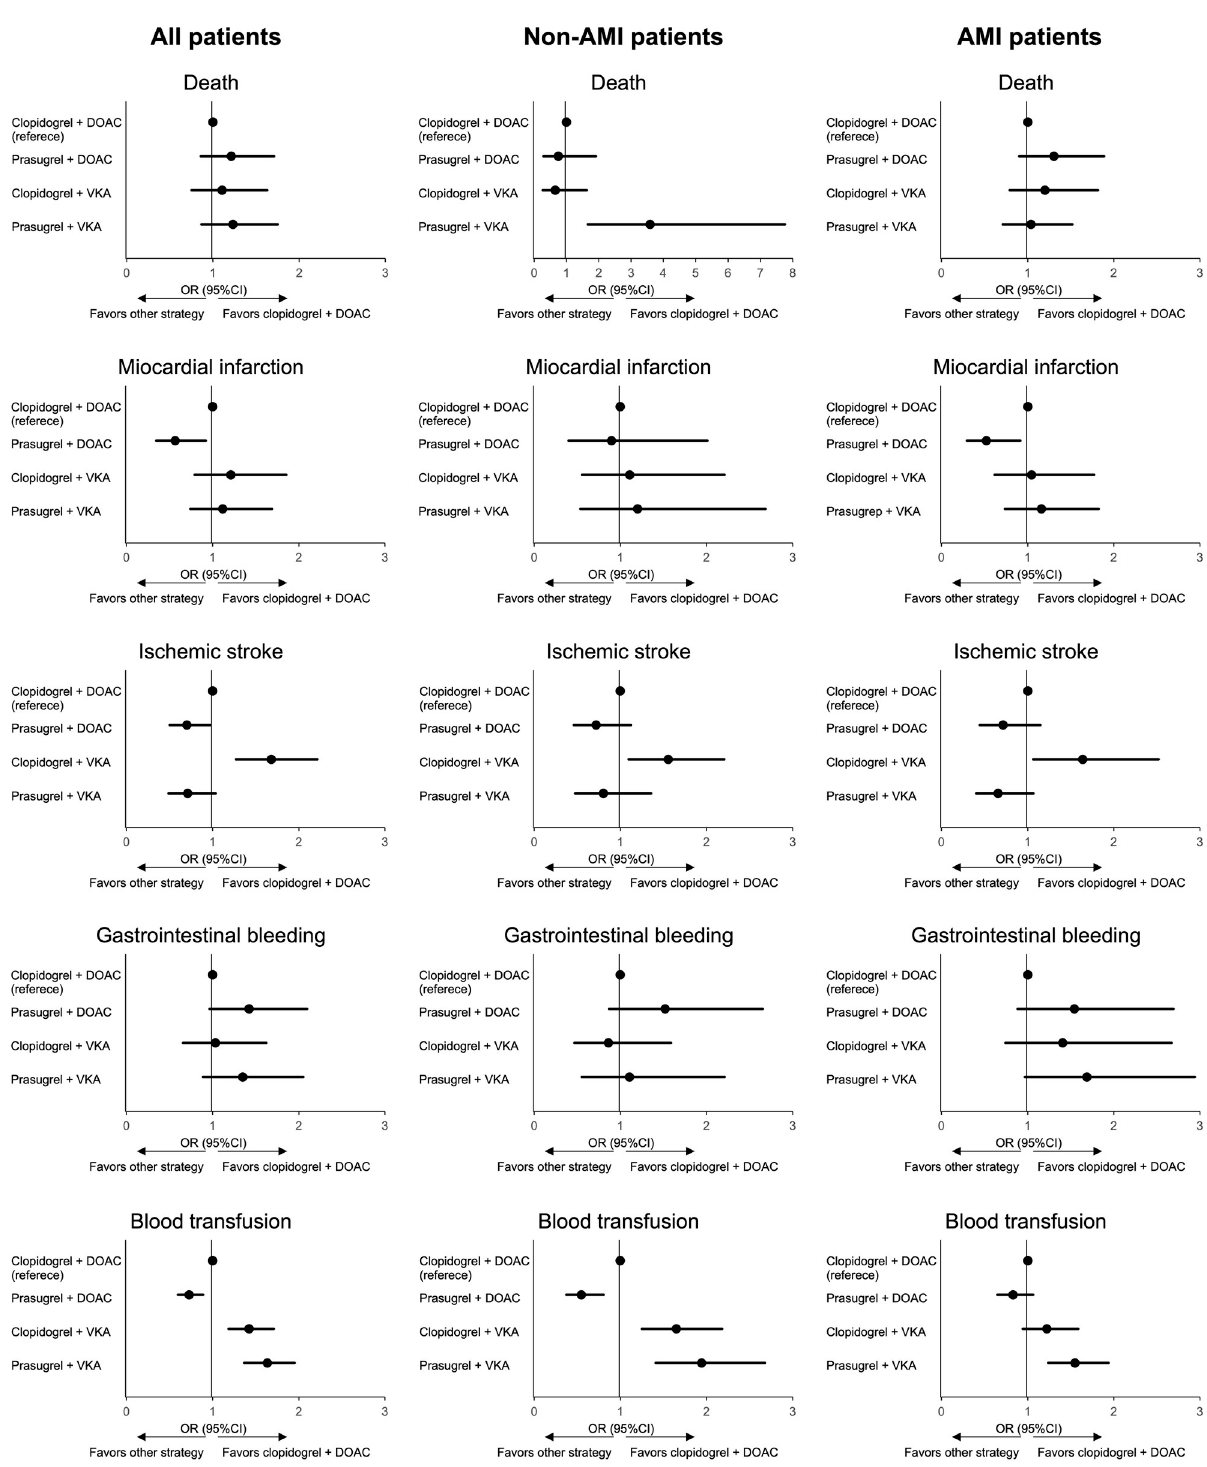
Fig 2. Impact of the combination of P2Y12 inhibitor and OAC on in-hospital adverse events. The incidence of in-hospital adverse events, including death, myocardial infarction, ischemic stroke, gastrointestinal bleeding, and blood transfusion, was compared between the 2 specific regimens with the clopidogrel/DOAC group as reference in all patients, AMI patients, and non-AMI patients. AMI: acute myocardial infarction, DOAC: direct oral anticoagulant, VKA: vitamin K antagonist.